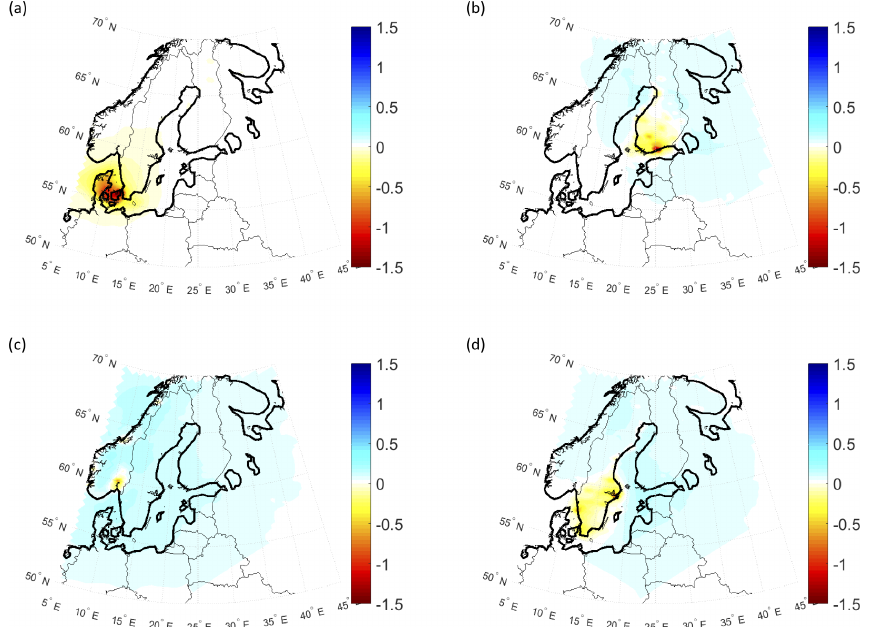
Figure 11. Spatial distributions of annual population-weighted mean absolute contributions (µgm − 3 ) of total emissions from (a) Denmark, (b) Finland, (c) Norway and (d) Sweden to surface O 3 levels in the Nordic